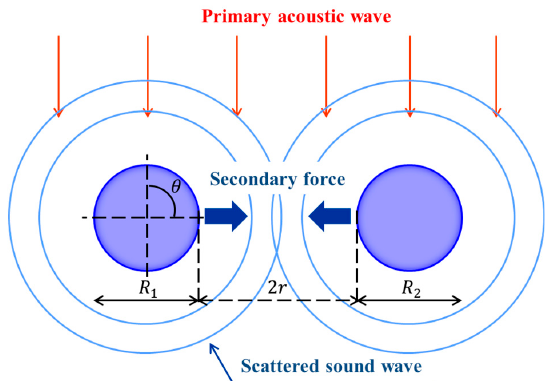
Figure 6. A schematic illustration of the secondary force in the present study. The secondary force on the droplets was calculated by assuming θ = 90°.